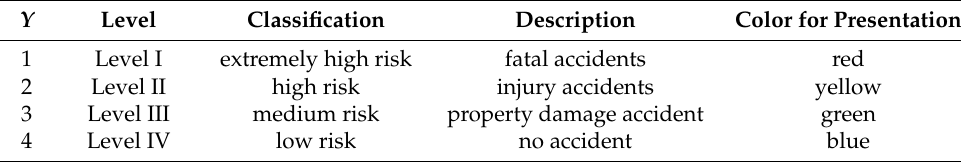
Table 1. Real-time risk levels for hazmat road